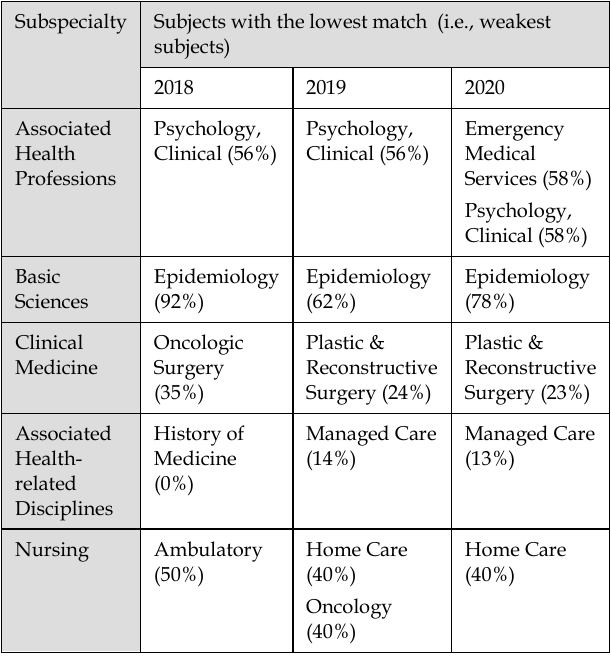
Table 5 Weak areas per subspecialty Subspecialty